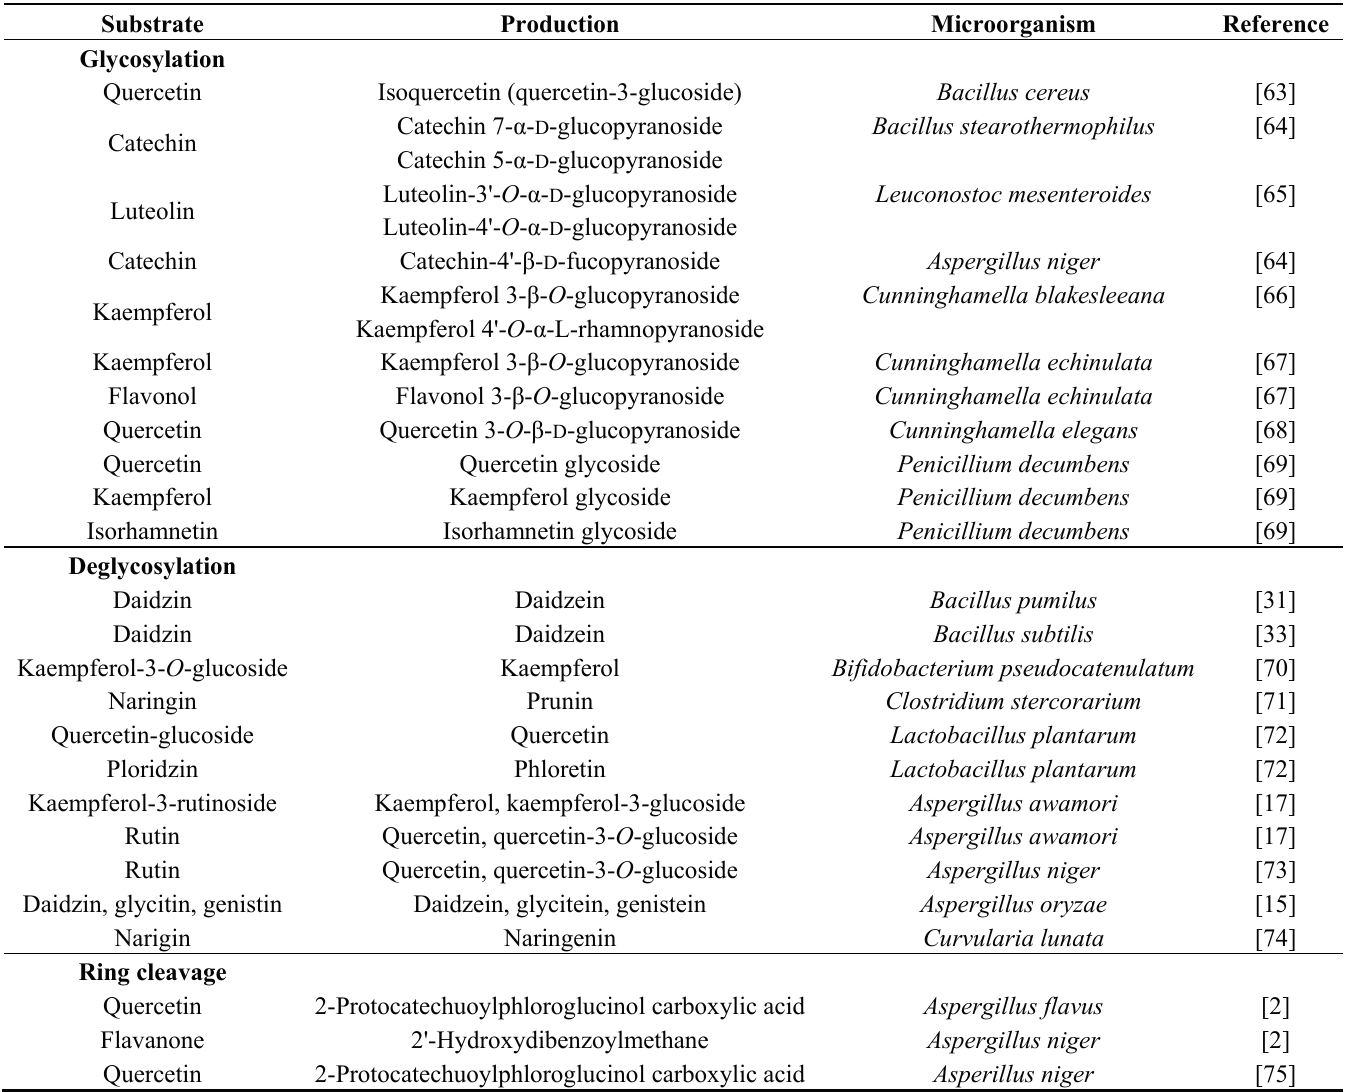
Table 3. Microbial metabolism of flavonoids through fermentation